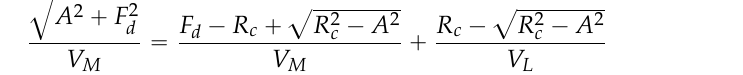
Figure 2. Schematic diagram to determine the radius of lens curvature for the proposed double-focused transducer.